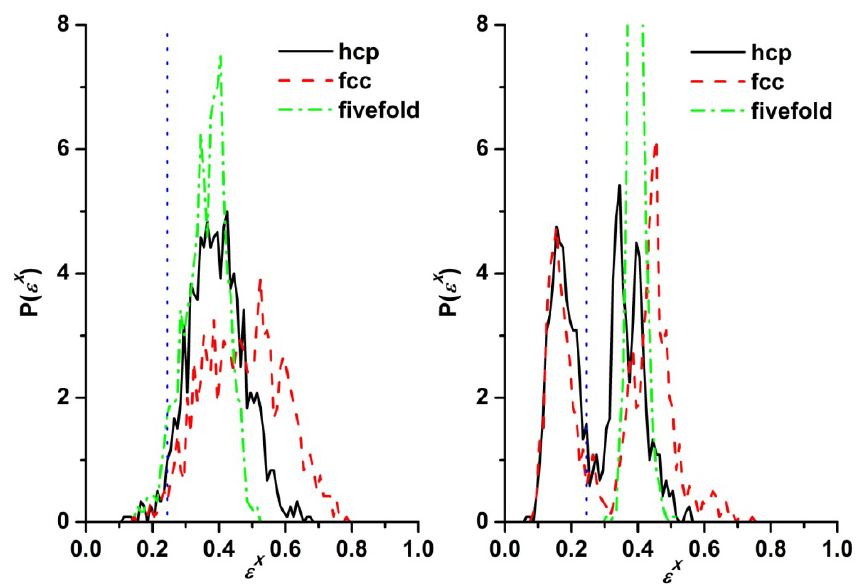
Figure 2. Same as in Figure 1 but at a packing density of